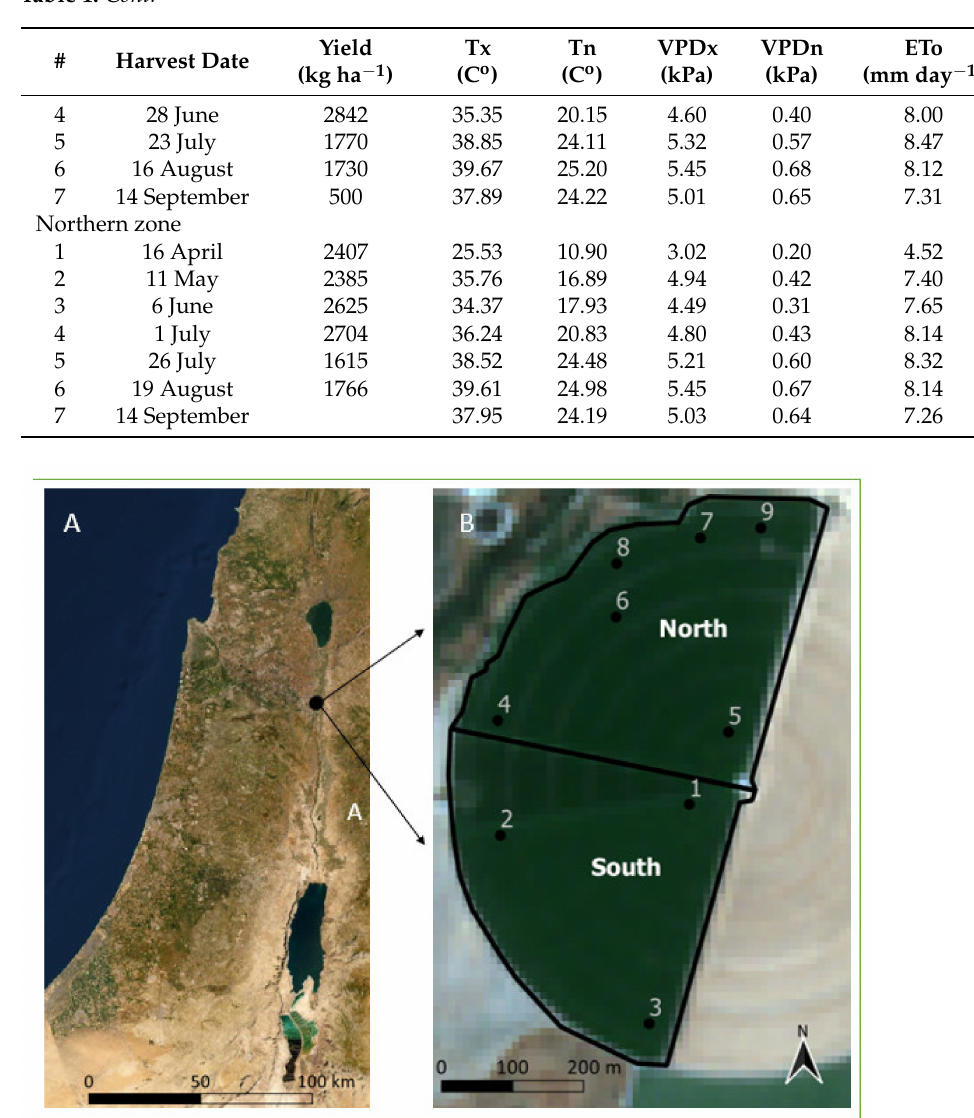
Figure 1. The alfalfa field’s location ( A ) with the management zones and the measurement sites ( B ). The background image was made by Sentinel-2 on 30 May 2021, with the center pivot north of sites 1 and